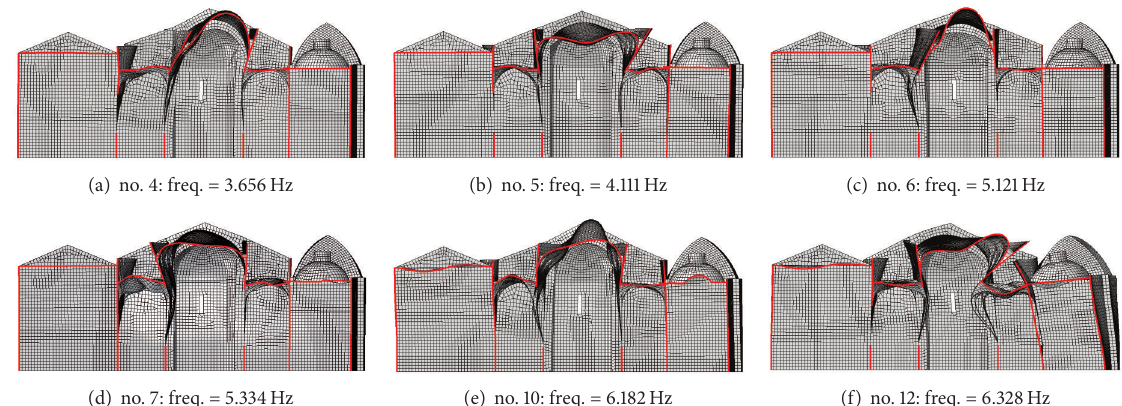
Figure 7: Linear dynamic analysis: transversal section of the of the main six eigen-modes.